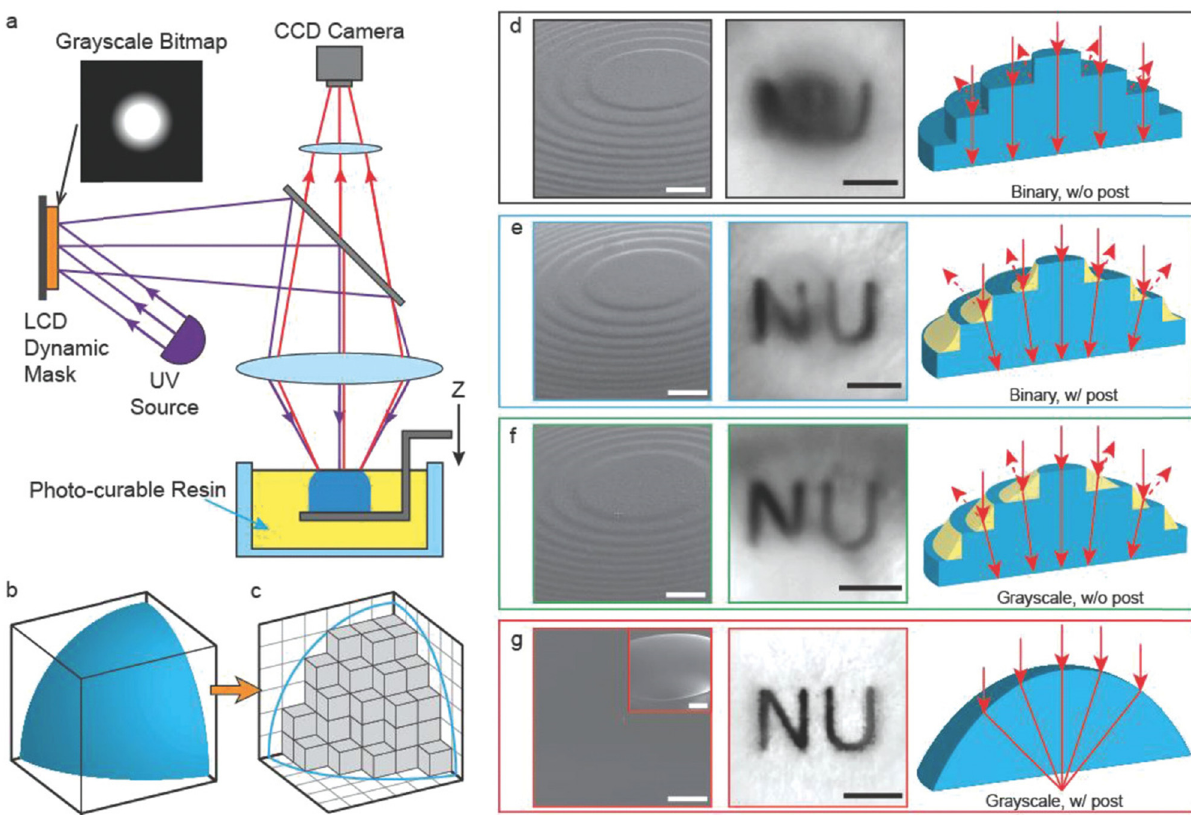
Figure 2: 3D printing of an optically smooth surface using the PµSL system and post - processing steps. ( a ) Schematic illustration of the PµSL system. A 3D solid model with smooth surfaces shown in panel ( b ) is approximated as a set of discrete voxels, resulting in the pixelated rough surface shown in ( c ) . ( d – g ) Surface roughness optimization and the resulting imaging characteristics of 3D - printed lenses using various methods. ( d ) Lens printed by binary patterns without post - curing process; ( e ) lens printed by binary patterns and the following meniscus equilibrium post - curing process. The polymerized meniscus structures are illustrated in yellow; ( f ) lens printed by grayscale photopolymerization without the meniscus equilibrium post - curing process, with the grayscale polymerization providing a smooth tran - sition from the pixelated roughness ( marked yellow ) ; and ( g ) lens printed by grayscale photopolymerization and the following meniscus equilibrium post - curing process. The fi rst column in panels ( d – g ) shows SEM images of the surface of the printed lenses. Scale bars: 200 µm for panels ( d – g ) , 1 mm for the inset of panel ( g ) . The second column in panels ( d – g ) shows the recorded images of the printed “ NU ” from